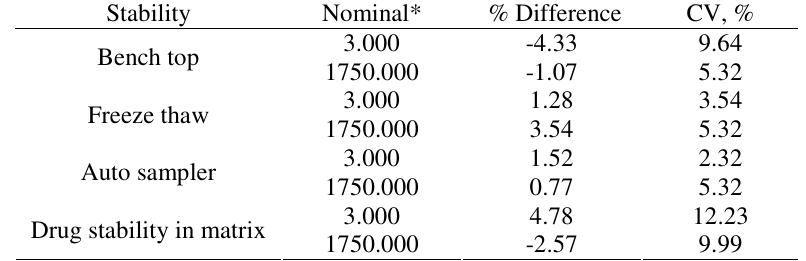
Table 4. Concentrations of metolazone in stability sample prepared in human plasma